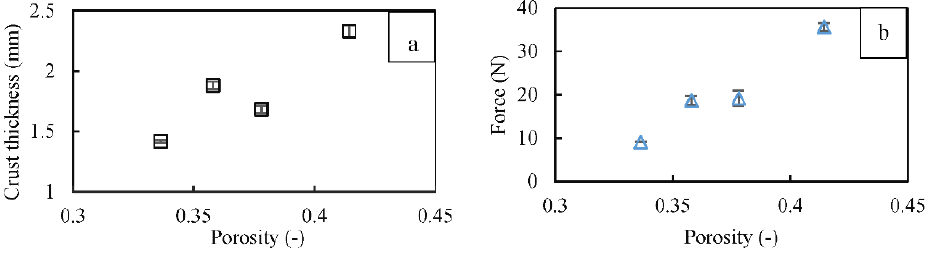
Figure 9. Variations in ( a ) crust thickness and ( b ) penetration failure force for FS30-treated sample with different soil porosity values.